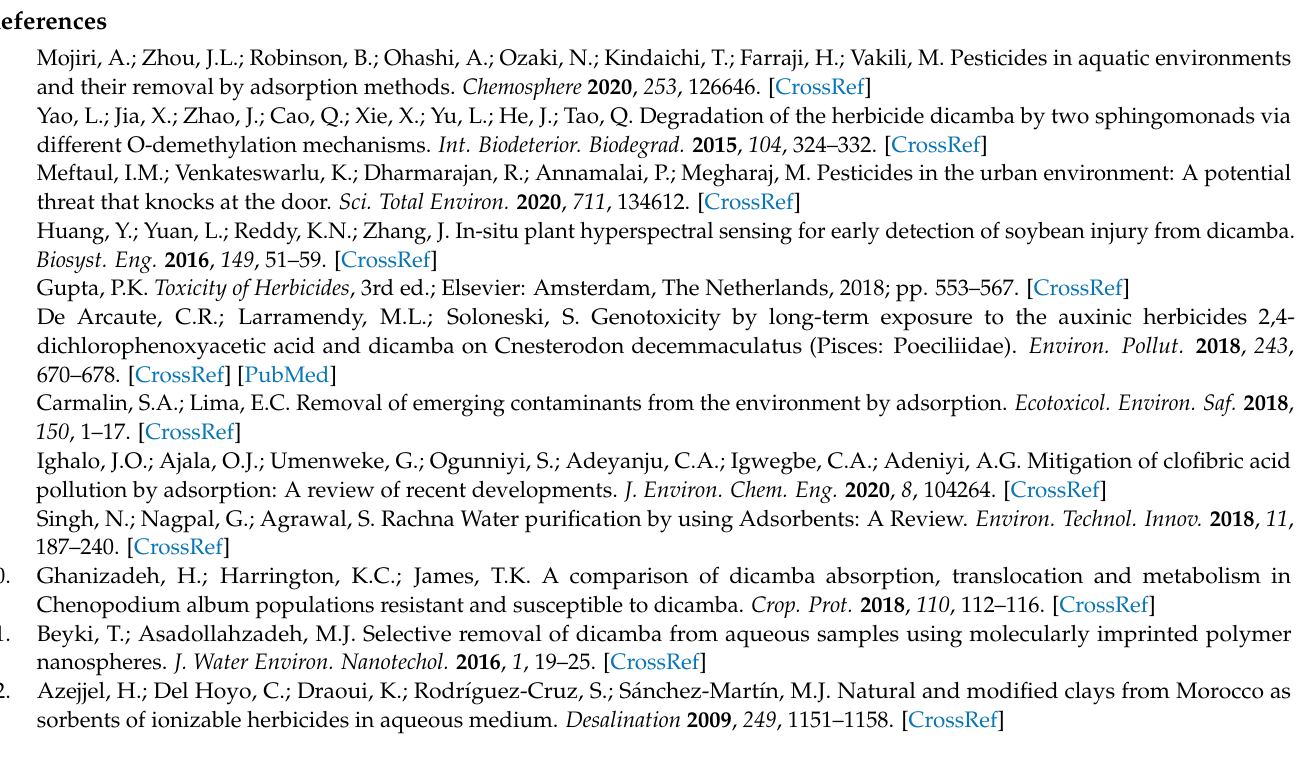
Table S1: Isotherm parameters for adsorption of dicamba onto MIL-101(Cr); Table S2: Coded range for independent variables for the CCD-RSM design